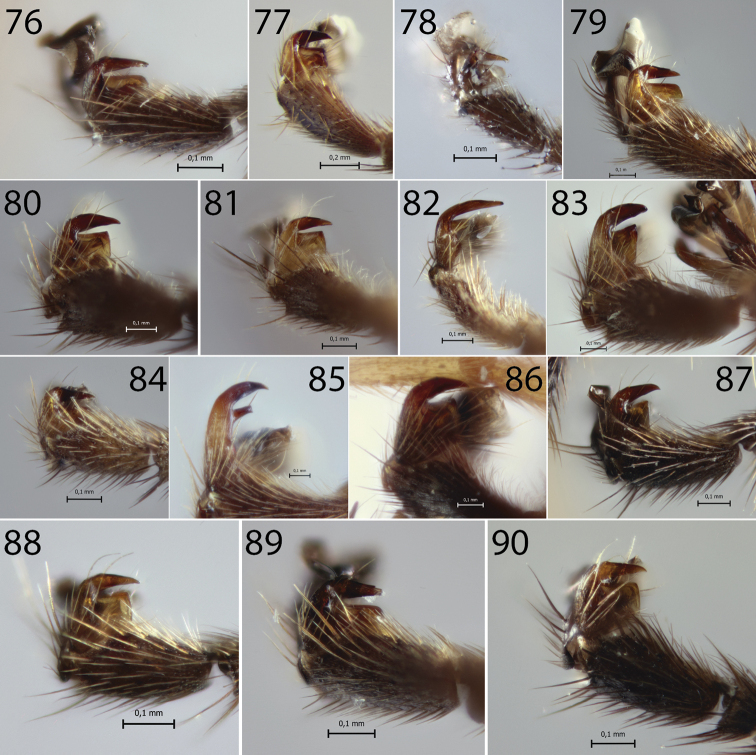
Tarsal claws of Hymenoepimecis spp. (females), lateral view 76H.
andina sp. nov. (holotype) 77H.
bicolor78H.
castilloi sp. nov. (holotype) 79H.
dolichocarinata sp. nov. (holotype) 80H.
duckensis81H.
ecuatoriana sp. nov. (holotype) 82H.
kleini83H.
longilobus sp. nov. (holotype) 84H.
manauara85H.
neotropica86H.
pucallpina sp. nov. (holotype) 87H.
rafaelmartinezi sp. nov. (holotype) 88H.
ribeiroi89H.
tedfordi90H.
uberensis.